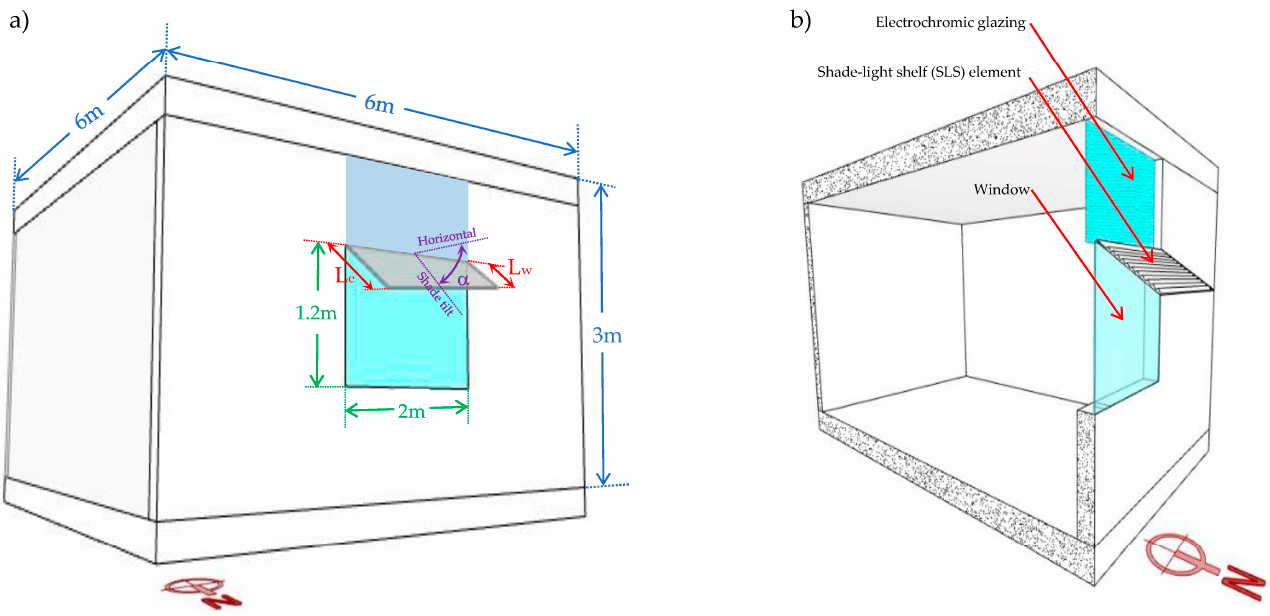
Figure 2. ( a ) The case model of a dwelling conditioned space of 6 m × 6 m × 3 m; and ( b ) the components of the shade–light shelf system concept. (For shade–light shelf surface detail, see Figure 5). The daylight penetration was divided into two parts, an electrochromic area (on the top) and ordinary glazing (at the bottom—Figure 2). When the reflected sunlight off